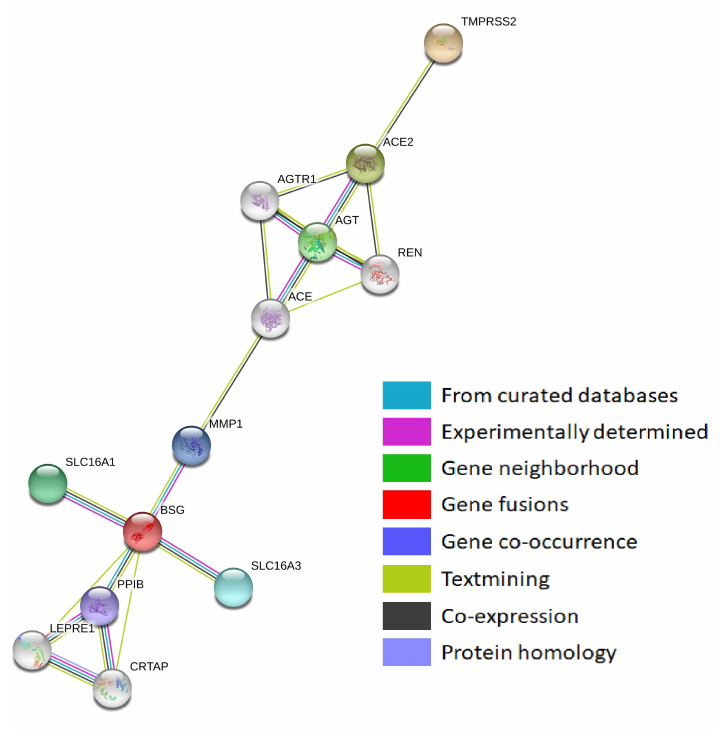
Figure 2. Protein–protein interaction network of SARS-CoV-2-interacting genes